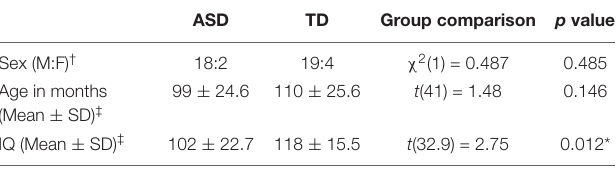
TABLE 1 | Subject demographics and group comparisons. ASD TD Group comparison p value